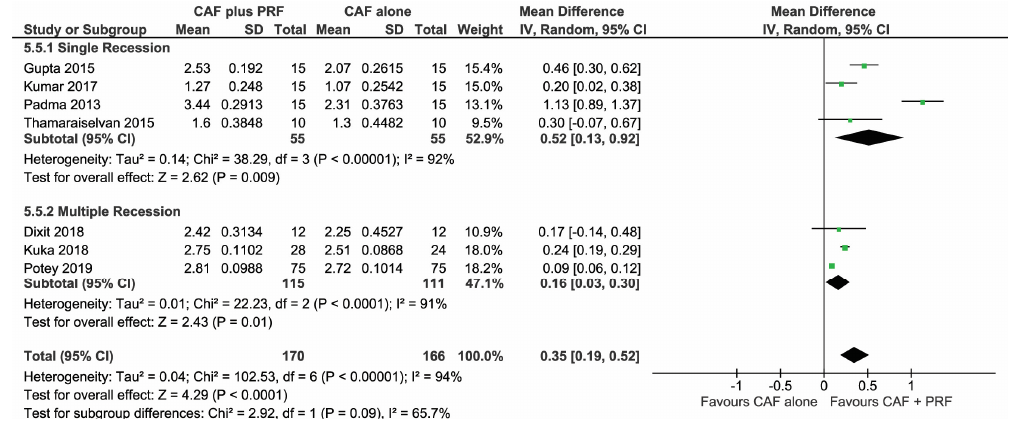
Figure 6. Comparison of change in recession depth (RD) between CAF + L-PRF versus CAF alone with 6–12 months follow-up.